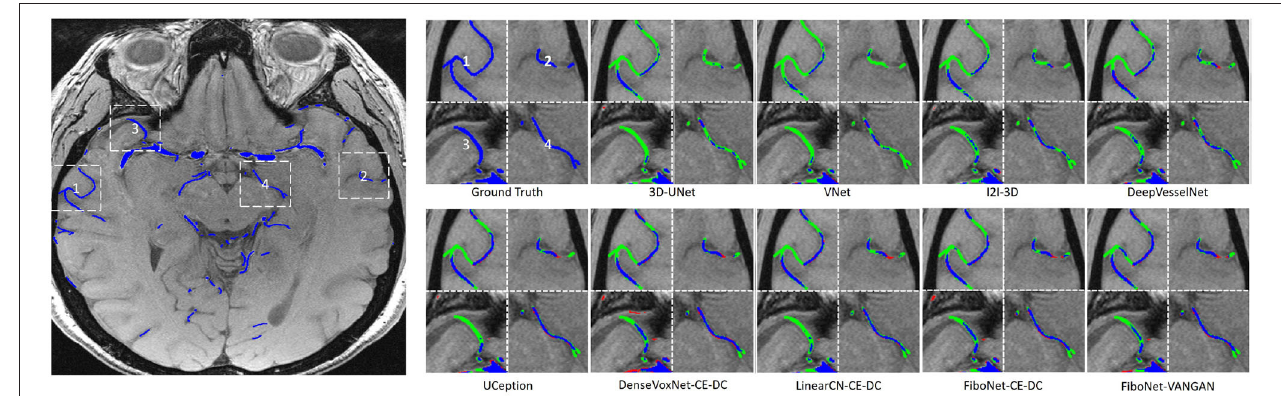
FIGURE 5 | Visual results of the four different white dash-line rectangles of each method. Pixels in blue represent true positives. Pixels in green represent false positives. Pixels in red represent false negatives.